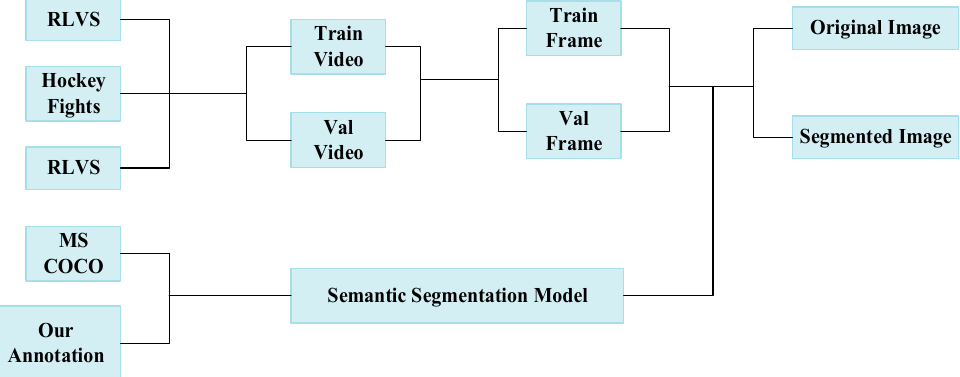
Figure 4. The process of removing the background of the violent-behavior dataset.